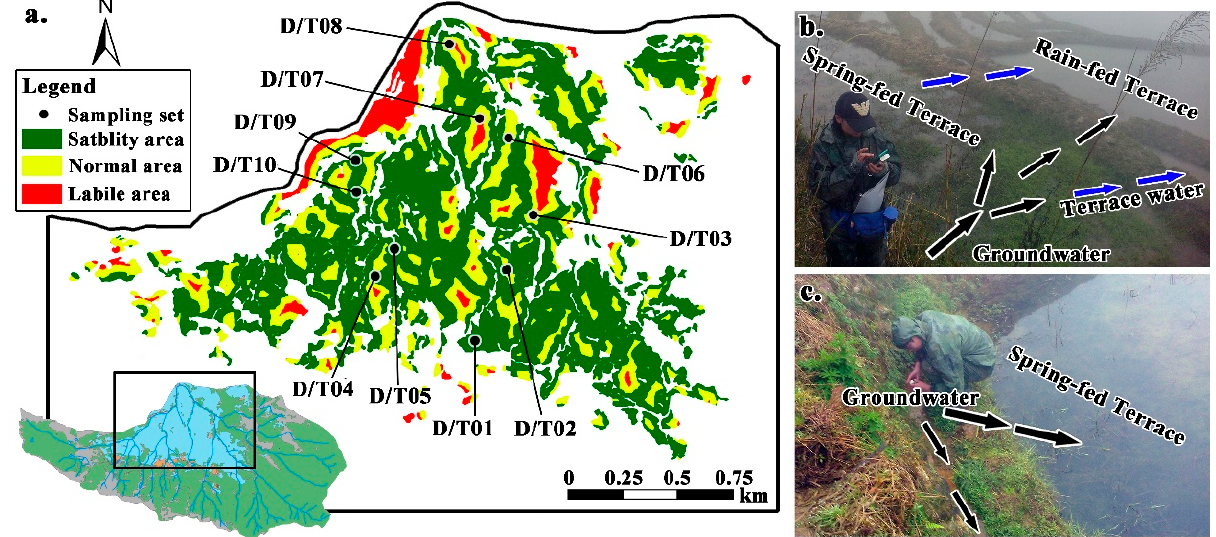
Figure 9. ( a ) Map showing the location of terrace water sampling sites at the water stability zoning (data on water stability zoning were taken from Wang [47]). ( b ) Indirect recharge of groundwater to rain-fed terraces, ( c ) direct recharge of groundwater to rain-fed terraces.